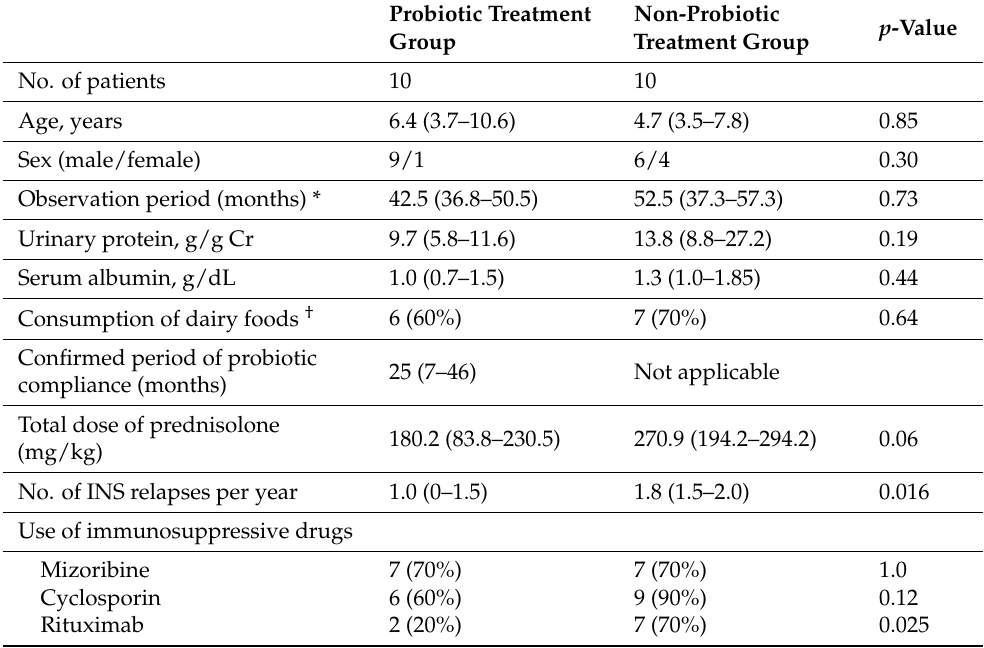
Table 1. Characteristics of idiopathic nephrotic syndrome (INS)